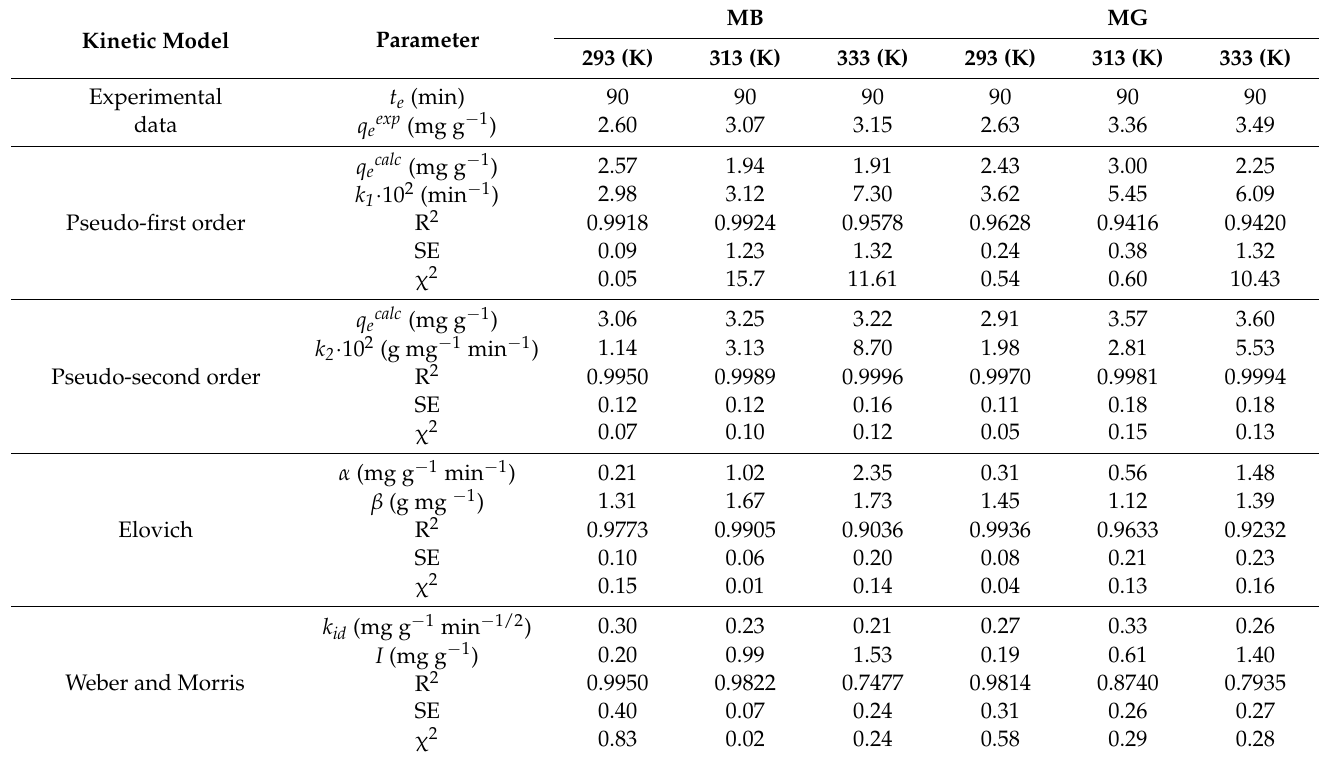
Table 3. Comparison of the kinetic